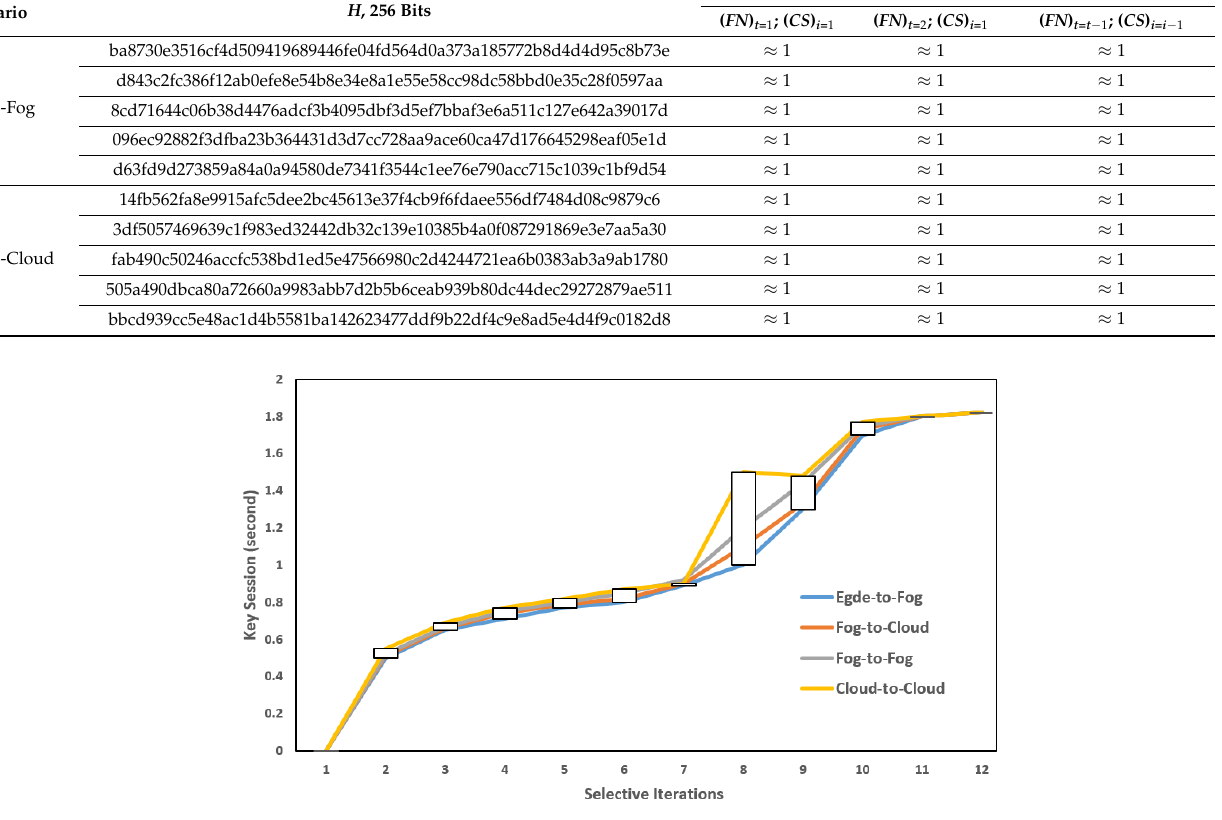
Figure 10. Performance results per communication scenario: session key = 2 s; time periods: 10, 20, and 30 min.